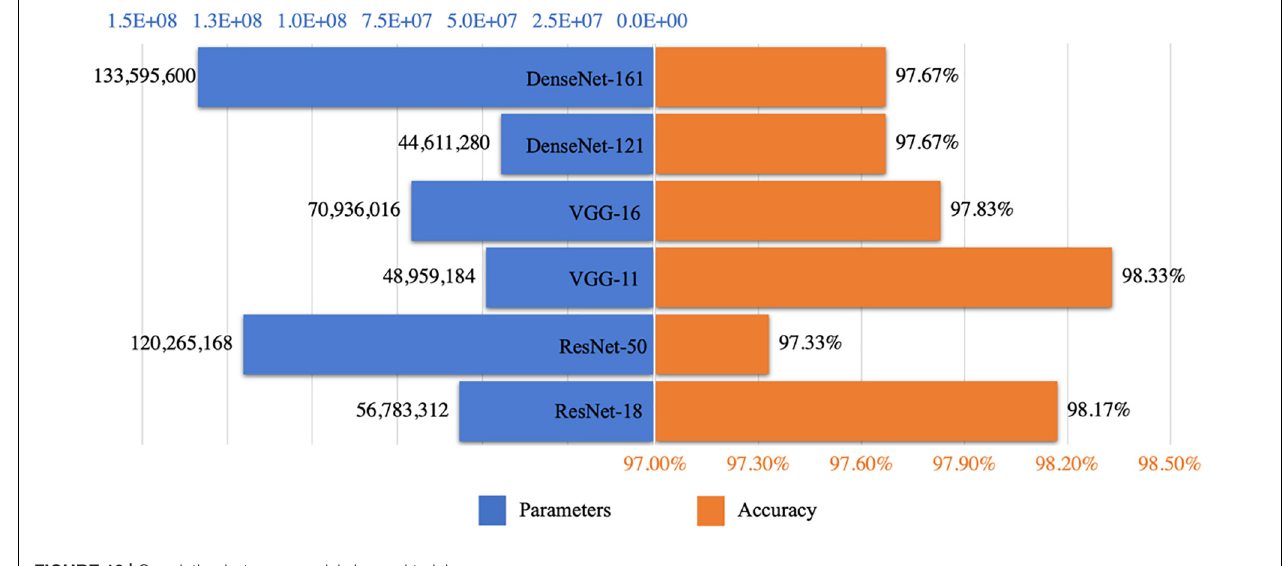
FIGURE 10 | Correlation between model size and training accuracy.